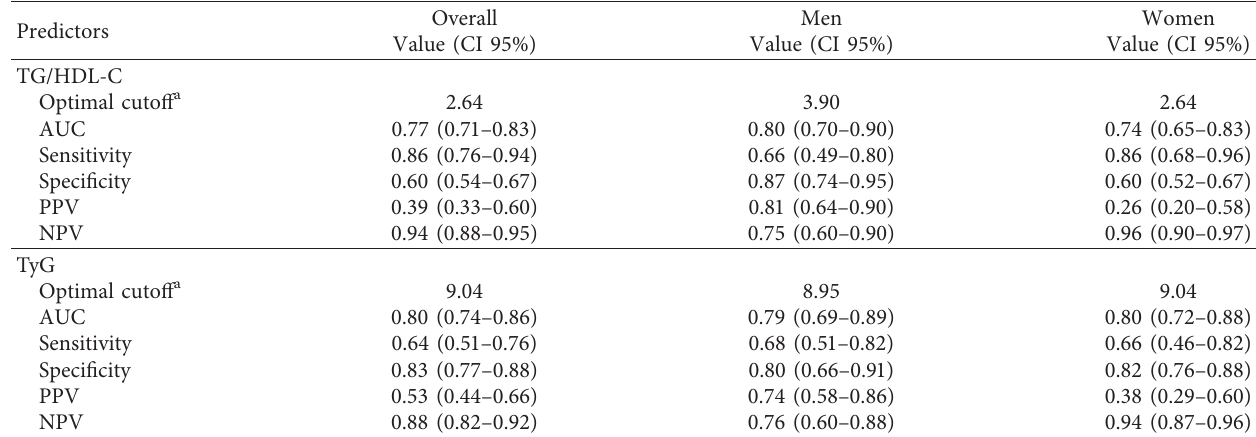
Table 4: Diagnostic accuracy of TG/HDL-C and TyG in predicting lifetime cardiovascular risk and their optimal cutoff values.